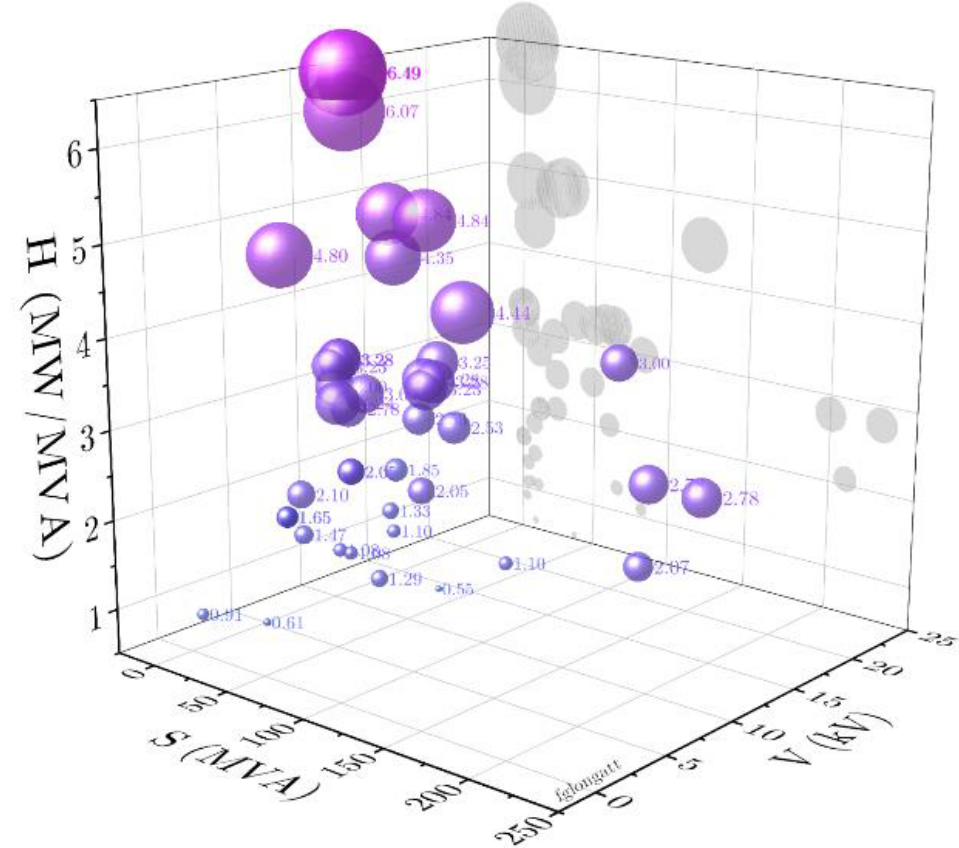
Figure 7. Representation of the rotational inertia versus rated apparent power and rated voltage: Peruvian power system.